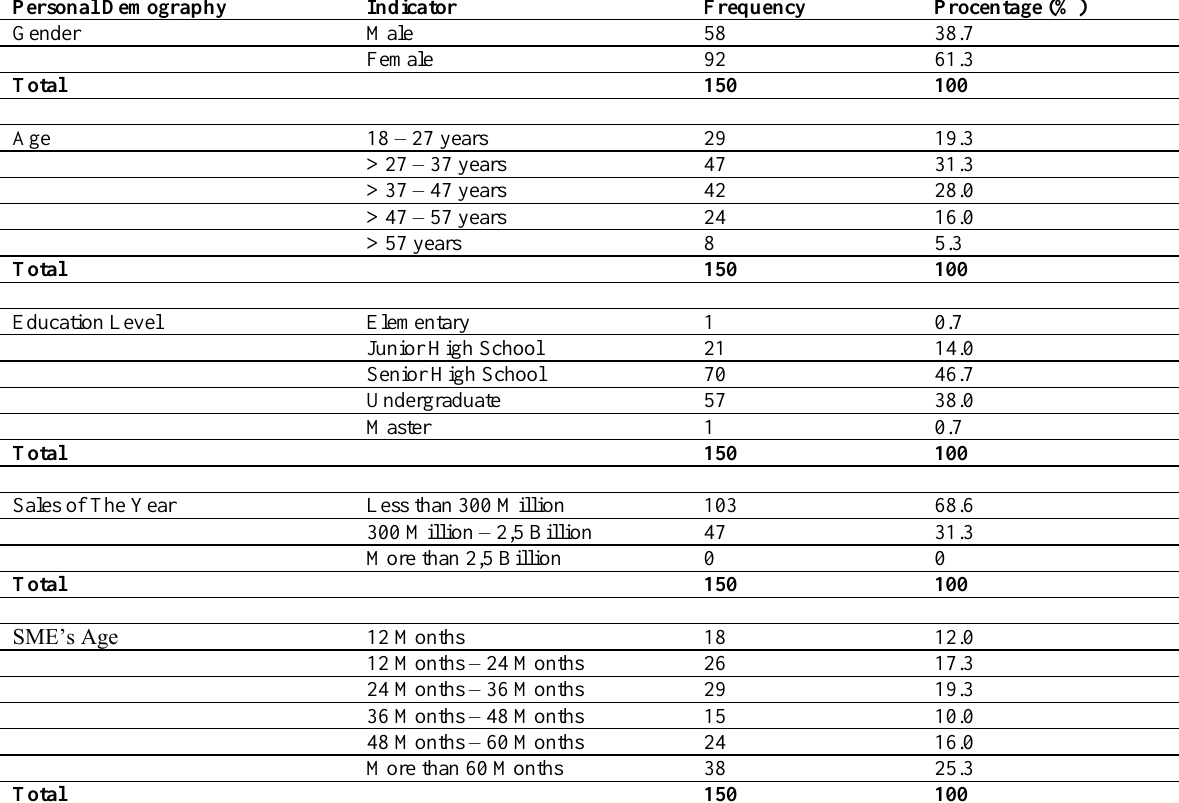
Table 1: Characteristics of